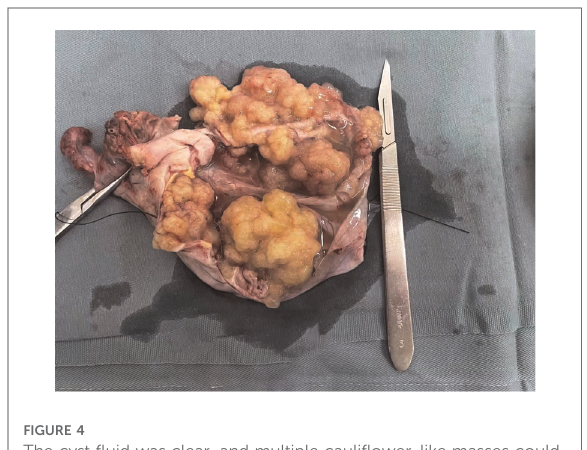
FIGURE 4 The cyst fl uid was clear, and multiple cauli fl ower-like masses could be seen on the cyst